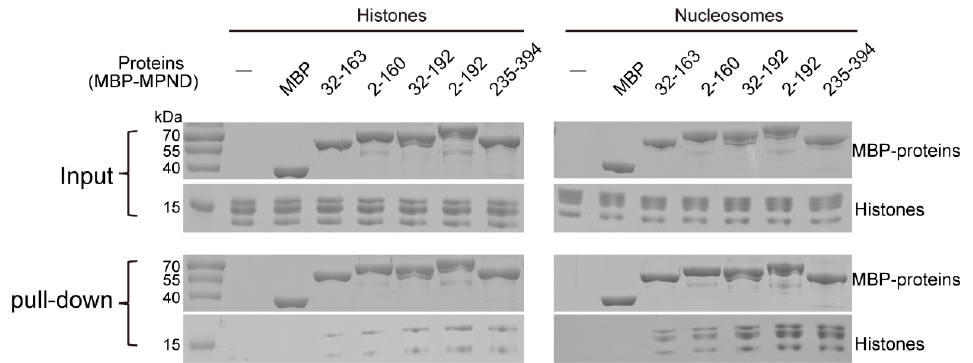
Figure 6. MPND interacts with histones or nucleosomes by MBP pull ‐ down assay. The different domains/regions in the MPND fragments used are as follows. MPND 32–163 : RAMA domain; MPND 2–160 : acidic region 1 and RAMA domain; MPND 32–192 : RAMA domain and acidic region 2; MPND 2–192 : acidic region 1, RAMA domain, and acidic region 2; MPND 235–394 : MPN domain. The concentrations of MBP ‐ MPND, histones, and nucleosomes used in the experiment were 0.5 μ M, 2.1 μ M, and 1.5 μ M, respectively. Input and eluted proteins were analyzed by SDS ‐ PAGE, followed by Coomassie Bright Blue staining. Note that MBP protein was taken as a control (CK).